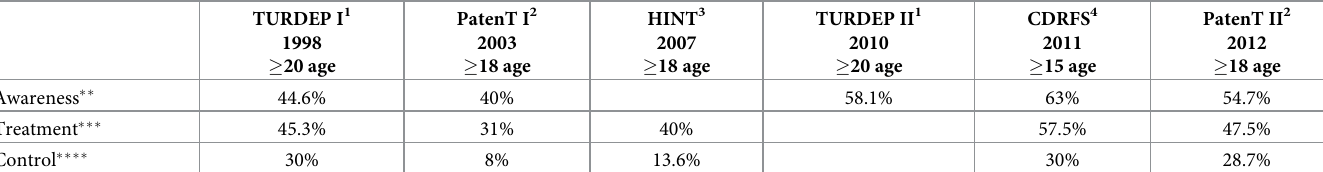
Table 2. Trends in awareness, treatment, and control of hypertension �